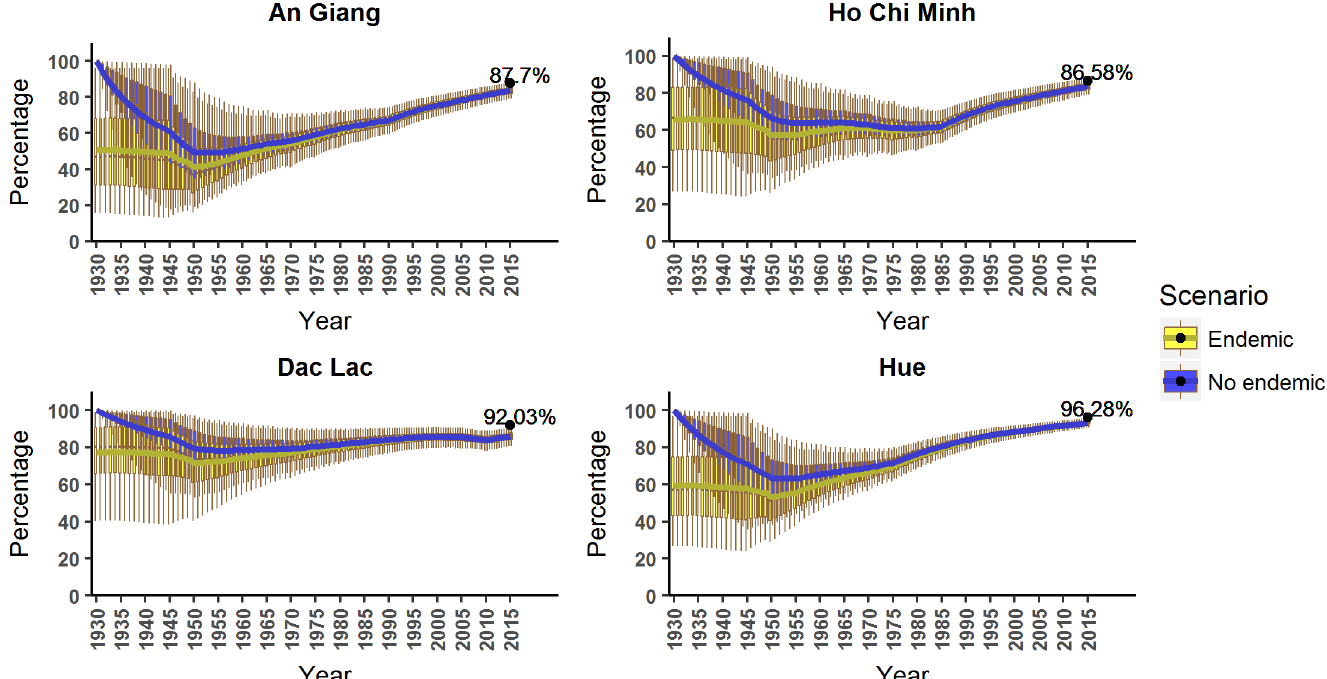
Fig 7. The predicted susceptible proportions over time from the best model in each location. In all locations, the boxplots represent the generated proportion with its 95% credible intervals (also shown 1 st quartile, 3 rd quartile, and the medians) with the solid lines showing the mean value of each interval. The two scenarios, with or without endemic transmission before in 1930 are shown in the plot by yellow and blue respectively. The black dots are the age-adjusted seropositive proportions from our serosurvey in 2015.